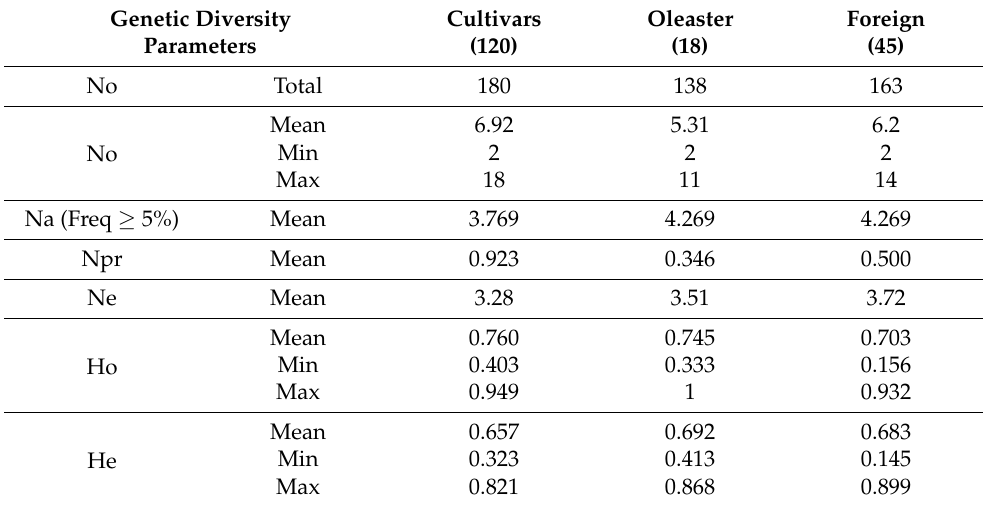
Table 1. Genetic diversity parameters found in different olive groups/populations: native olive cultivars, oleasters, and imported foreign olive